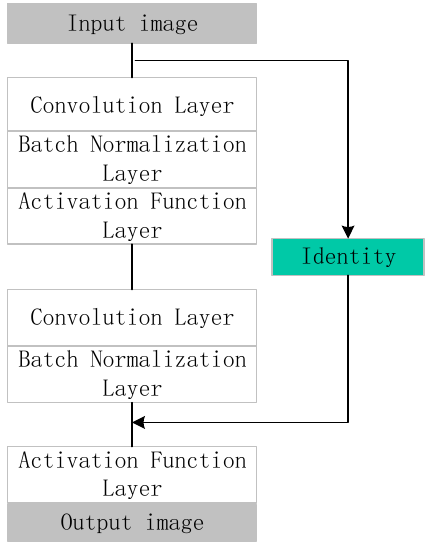
Figure 2. Schematic diagram of residual structure.